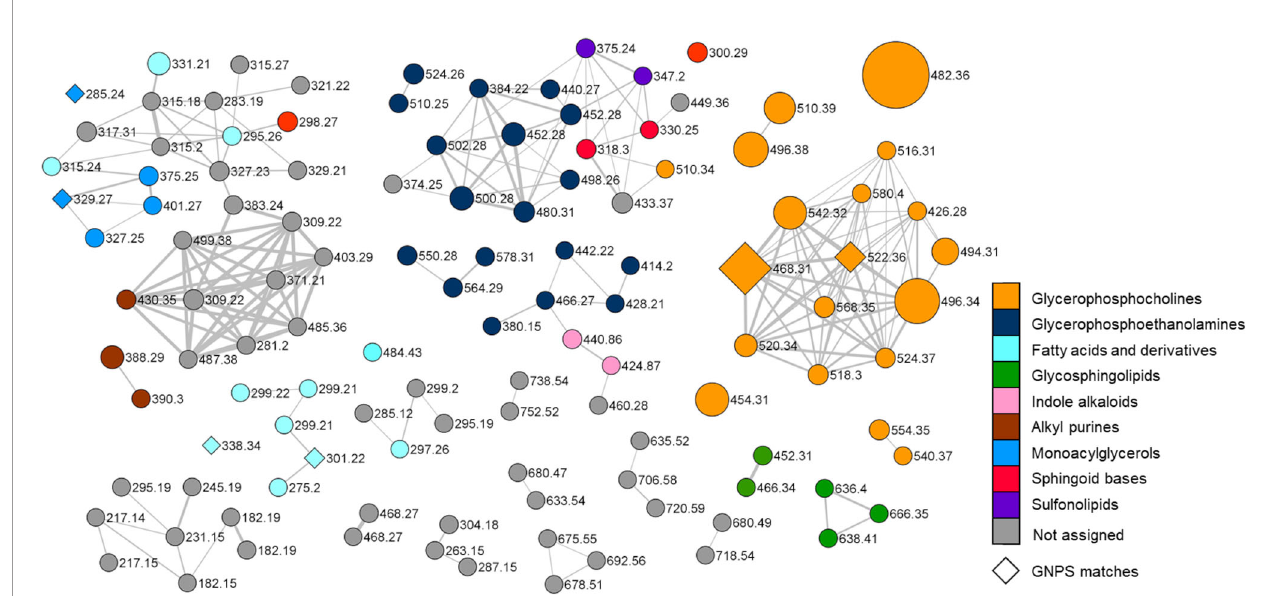
FIGURE 3 | Molecular network of the organic extract from Botrylloides niger . Nodes are labelled with parent mass and the colour of each node is mapped to chemical class assigned by integration of molecular networking data with extensive analysis of MS tandem spectra of the metabolites. Nodes annotated by the GNPS reference database are represented as diamonds. Edge thickness re fl ects cosine score similarity and node size is related to metabolite amounts (peak area).